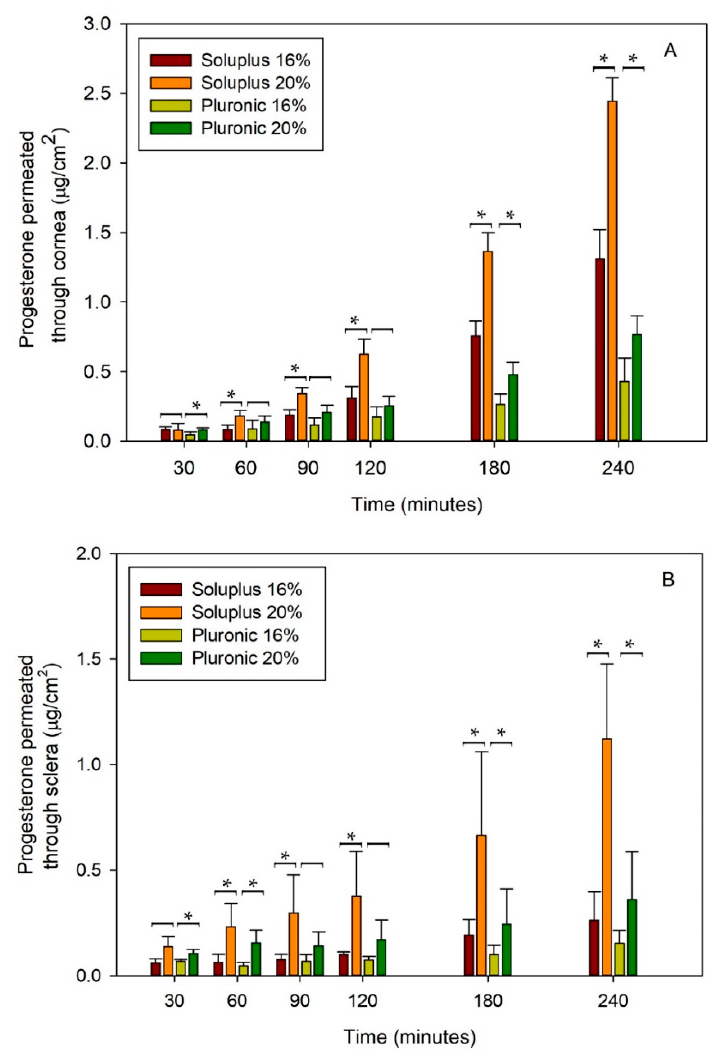
Figure 4. Trans-corneal ( A ) and trans-scleral ( B ) permeation of PG as a function of time when formulated in Soluplus or Pluronic F68 micelles ( n = 4). * Significant differences were found between 16% and 20% of either Soluplus or Pluronic.